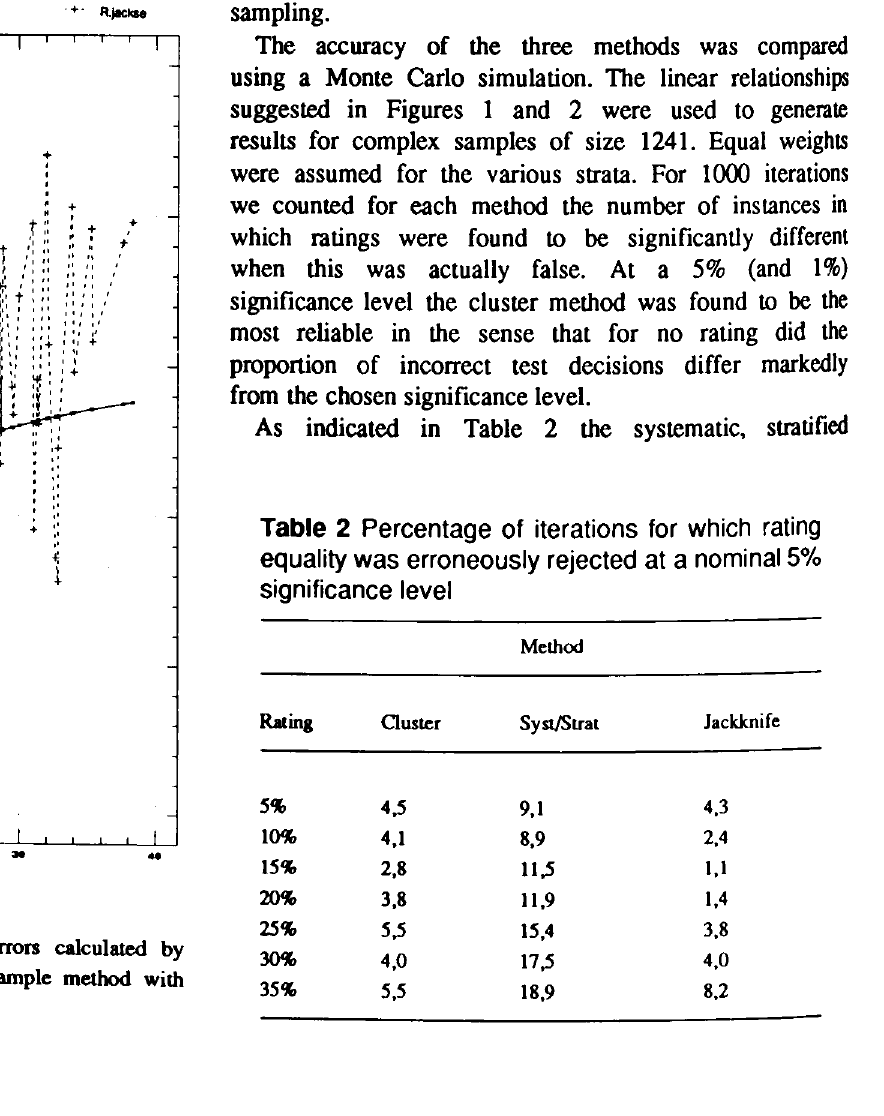
Flpre 6 Comparison of rating standard errors calculated by the jackknife method(+) 111d the random sample method